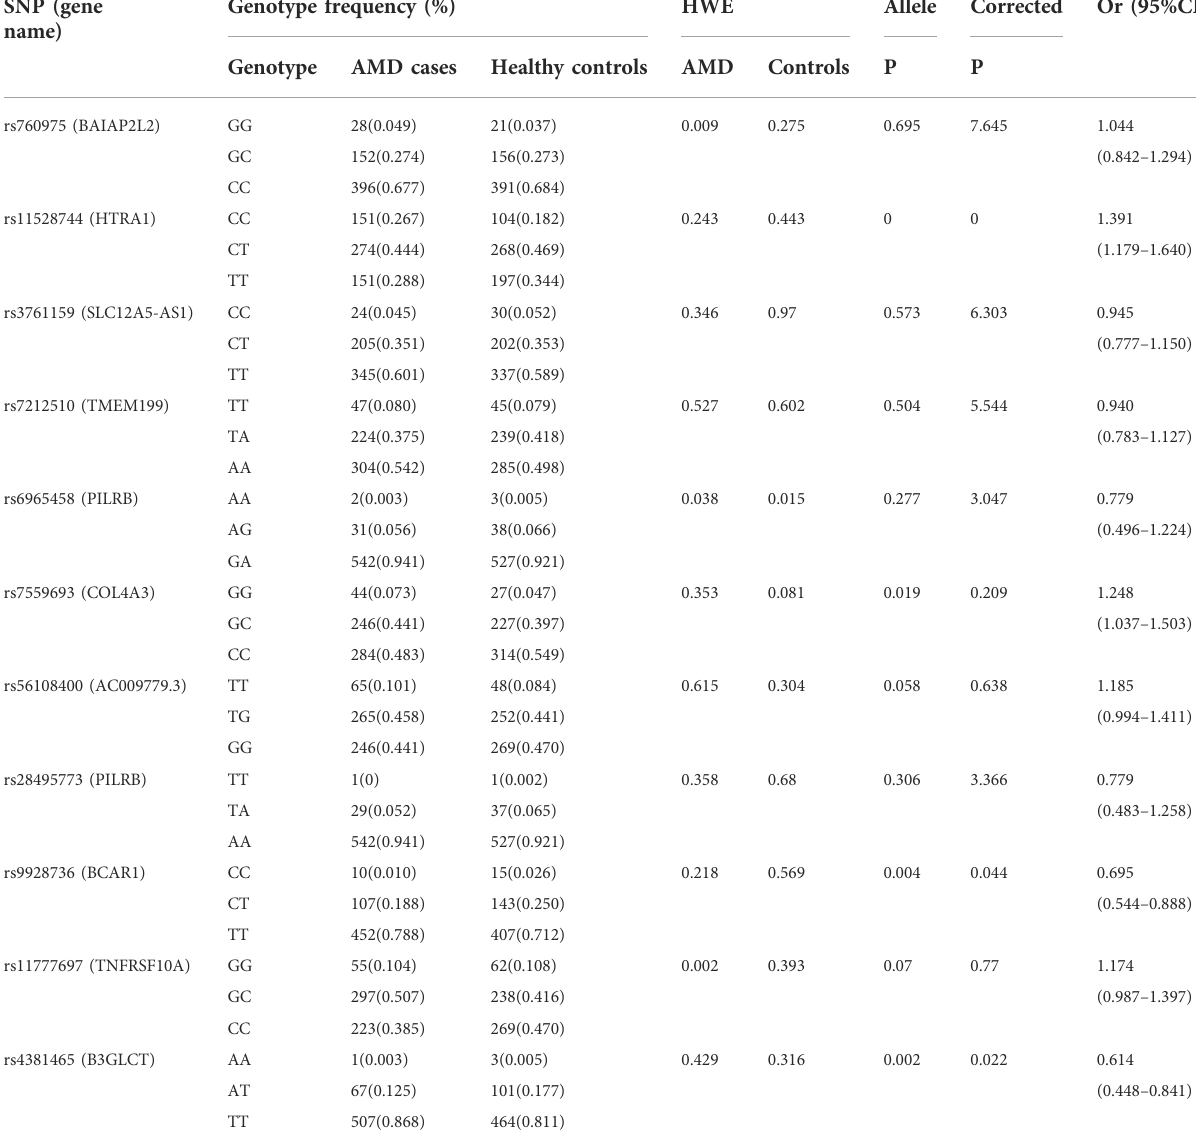
TABLE 3 The genotype frequencies and association analysis of 11 SNPs in AMD cases and